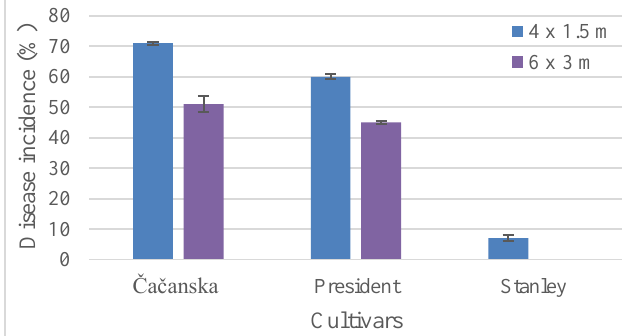
Figure 4. Incidence of shothole disease caused by Stigmina carpophila in 2017 (Debrecen-Pallag) Incidence of Polystigma rubrum There were no visible symptoms of blackhorn dotty in 2016 due to inadequate weather conditions for the Polystigma rubrum fungus. However, all the four cultivars were infected by Polystigma rubrum in 2017 ( Figure 5 ).